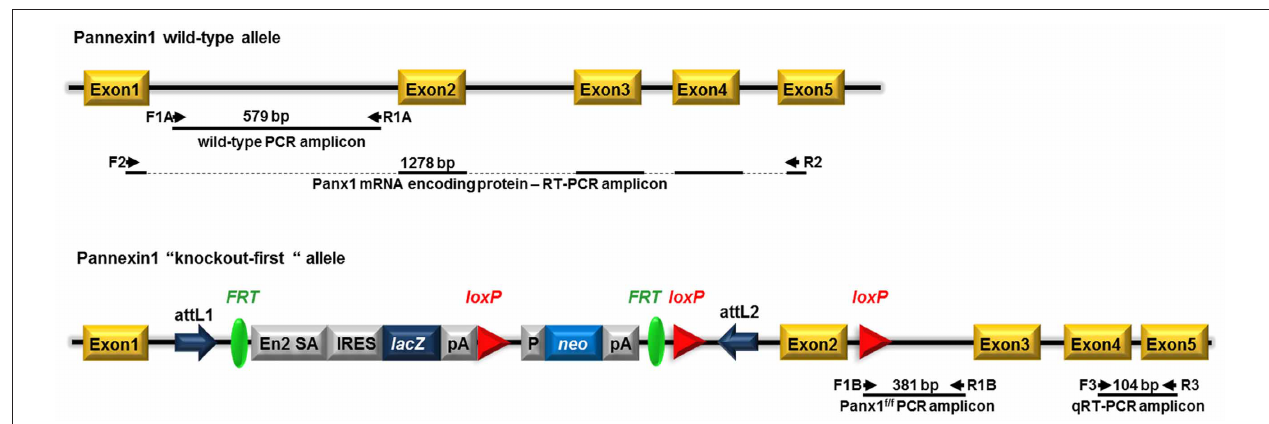
FIGURE 1 | Schematicviewof the Panx1wild-typealleleand the “knockout-first”conditionalalleleof Panx1 tm1a ( KOMP ) Wtsi mice. Pannexin1 ( Panx1 )geneconsists of 5 exons.Panx1 “knockout-first”allele was generated byKOMPthroughinsertionoftheL1L2_Bact_Pcassetteintothemouse Panx1 geneat position 15010456of Chromosome9. Thecassette is composedof 2FRT sites flankingan IRES: lacZ trappingcassette and a floxedhumanbeta actin promoter-driven neo cassette insertedinto the intron 1 of Panx1 andan additionalthird loxP site downstream,at position 15009768,of Panx1 exon2, thecritical exon.This“knockout-first”allele is designedto generatea Panx1 nullallele throughsplicing exon1 to a lacZ trappingelementand disrupting